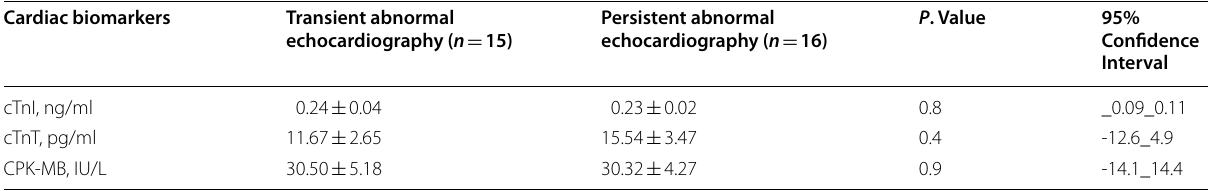
Table 5 Comparison of cTnI, cTnT and CPK‑MB in patients with transient vs. persistent abnormal